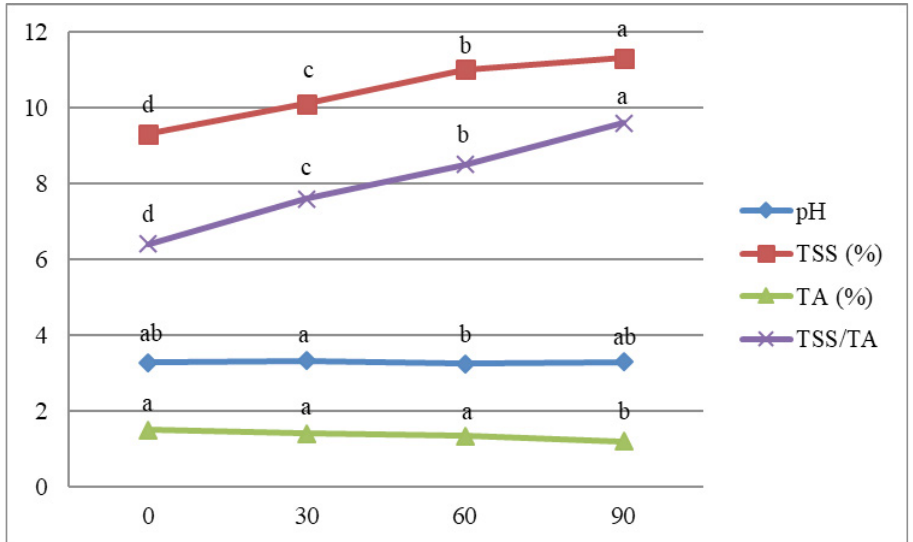
Figure 1: pH, TSS, TA and TSS/TA during 90 days of